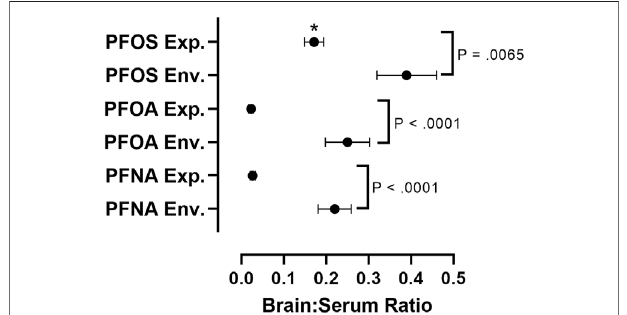
FIGURE 4 | Comparative assessment of average brain:serum ratios of long-chain PFAAs in experimental animal exposure studies vs. environmental exposure studies. Mean ratios represented by black circles with error bars representing ± standard error of the mean. A two-way analysis of variance (ANOVA) on log-transformed brain:serum PFAS ratios with long chain PFAA congener (PFOS, PFOA, PFNA) and exposure type (experimental animal exposure vs environmental exposure) revealed main effects of PFAA congener, F(2, 85)= 26.47, p < 0.0001,and exposuretype, F(1, 85)=114.7, p < 0.0001. A Š idák multiple comparisons post-hoc analysis with α = 0.05 indicated that environmental brain:serum ratios were greater than experimental brain:serum ratios for PFOS ( p = 0.0065), PFOA ( p < 0.0001), and PFNA ( p < 0.0001). Asterisks indicate that experimental brain:serum ratios of PFOS were greater than PFOA and PFNA ( p < 0.0001). Five outliers were removed, identi fi ed by the Rout method (1 experimental PFOS, three experimental PFOA, one experimental PFNA). Sample sizes varied across groups: PFOS experimental ( n = 33), PFOS environmental ( n = 11), PFOA experimental ( n = 15), PFOA environmental ( n = 11), PFNA experimental ( n = 11), PFNAenvironmental ( n =10).Detailsonexposurestudiescanbefoundin Supplementary Tables S2, S3